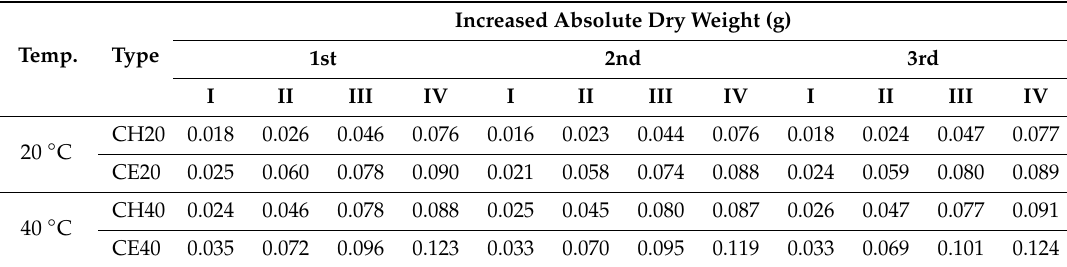
Table 3. Increased absolute dry weight of the CH and CE series by self-healing.